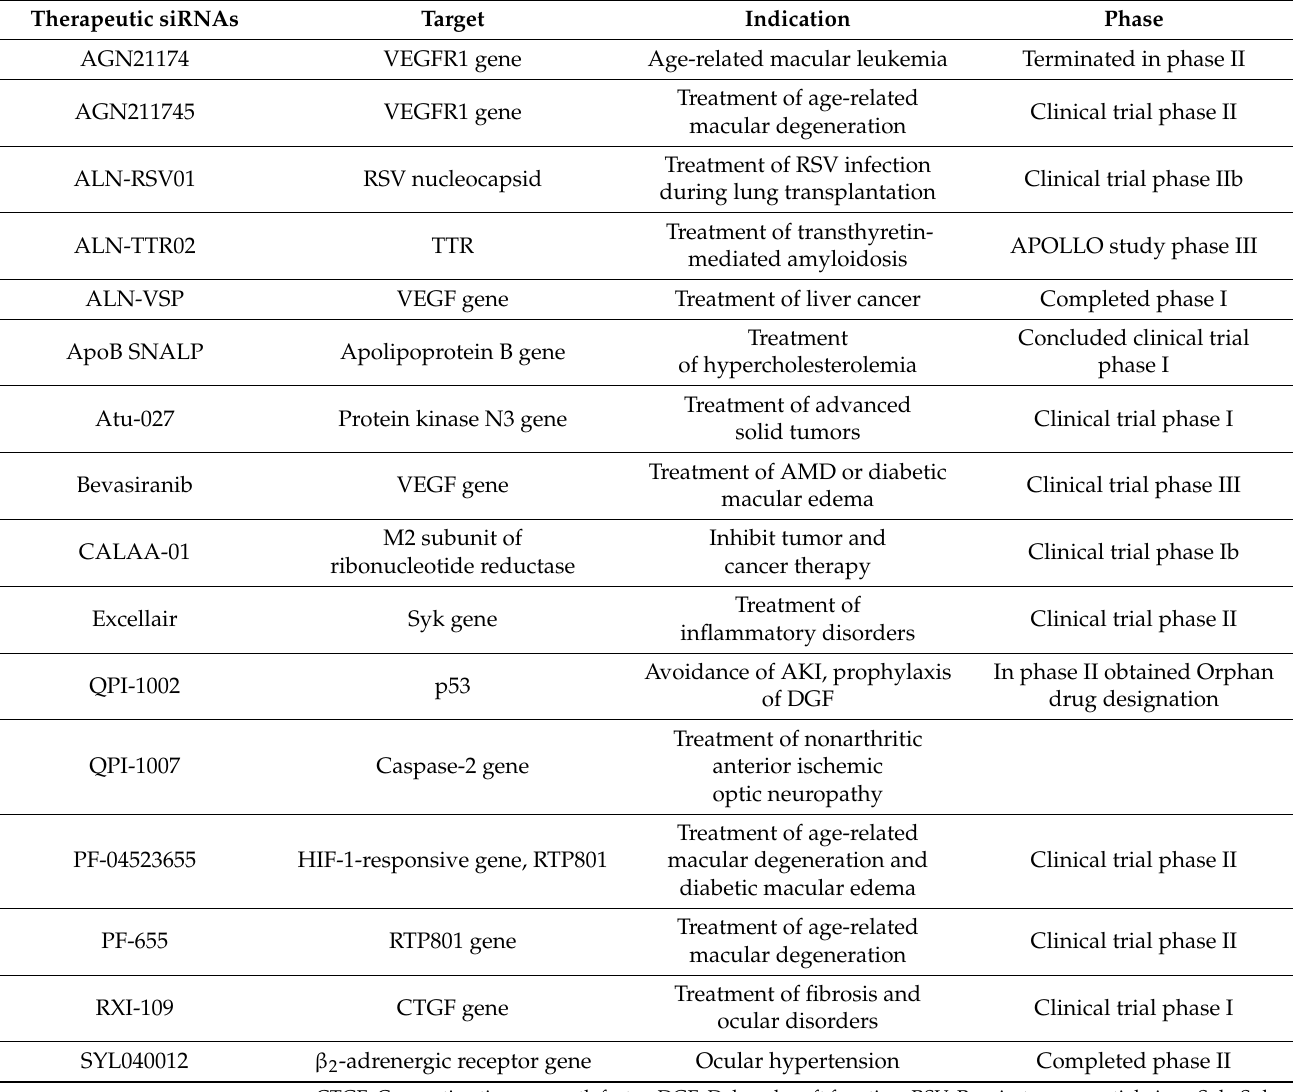
Table 8. Therapeutics siRNAs that are in a development phase, and their indication